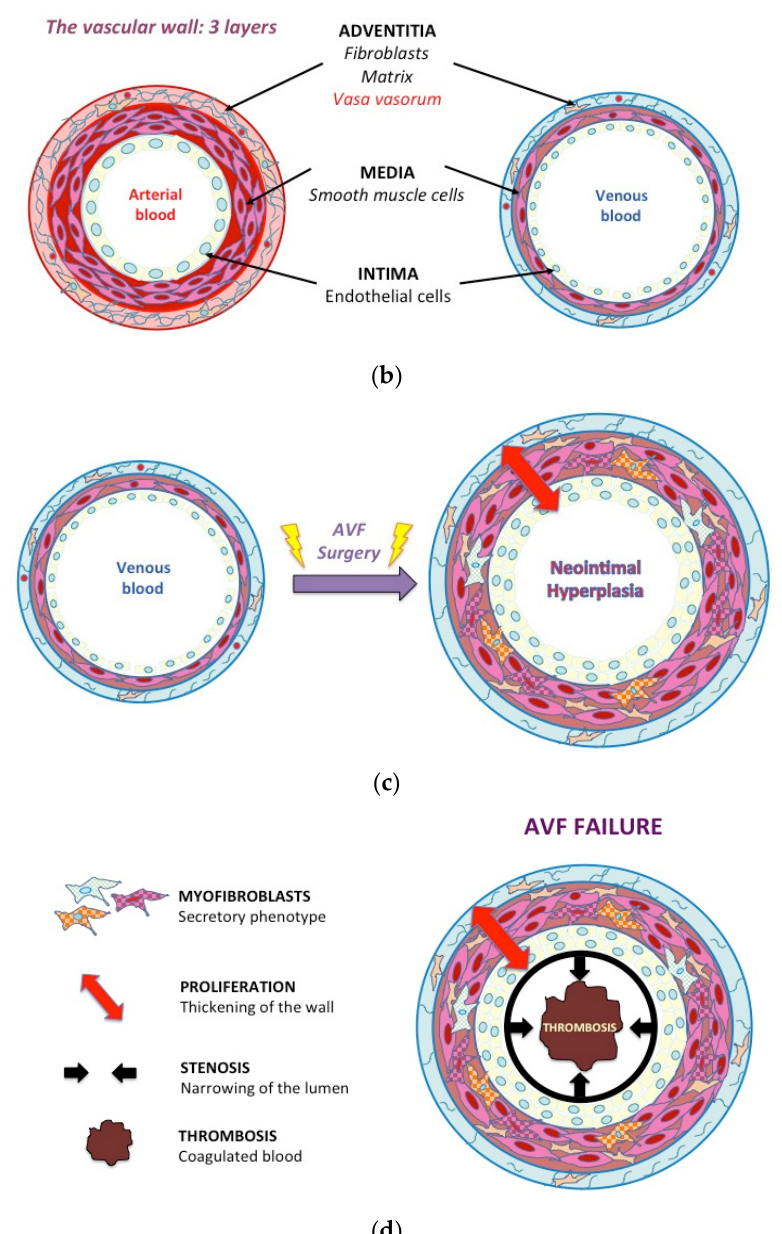
Figure 2. Mechanisms of venous wall remodeling. ( a ) Similar to the arterial wall, the venous wall is composed of three layers: the external layer, called the adventitia, composed of extracellular matrix (ECM), fibroblasts, immune cells, and vasa vasorum . The middle layer, called the media, is made of smooth muscle cells (SMC) and some extracellular fibers. The internal layer, also called intima, is composed of endothelial cells. ( b ) and ( c ), upon arteriovenous fistula (AVF) creation, in response to the altered hemodynamic environment, several structural changes occur in the vessel wall. Surgery induces endothelial denudation, matrix reorganization to accommodate outward expansion but also vascular SMC proliferation and migration, contributing to NH formation. ( d ) Aggressive intimal hyperplasia induces stenosis (narrowing) of the vessel that can provoke thrombosis